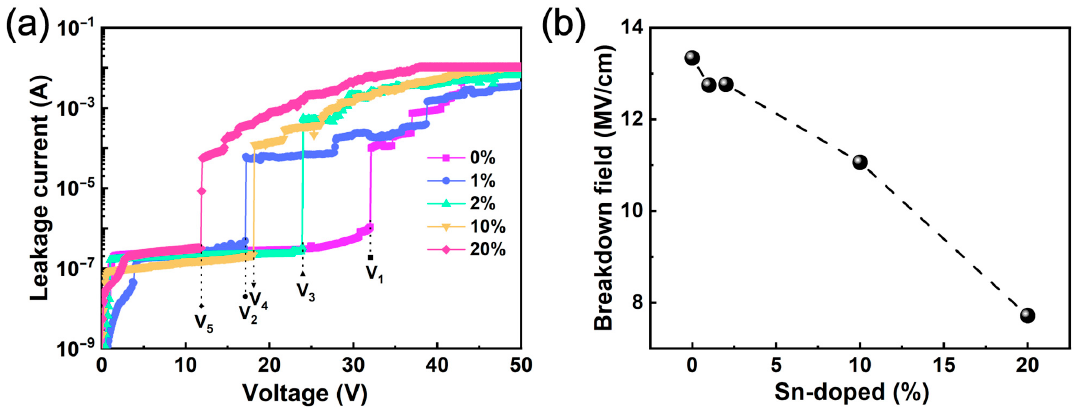
Figure 6. ( a ) I – V curves of the annealed Ga 2 O 3 thin films with different Sn compositions. ( b ) Break- down field as a function of Sn composition.